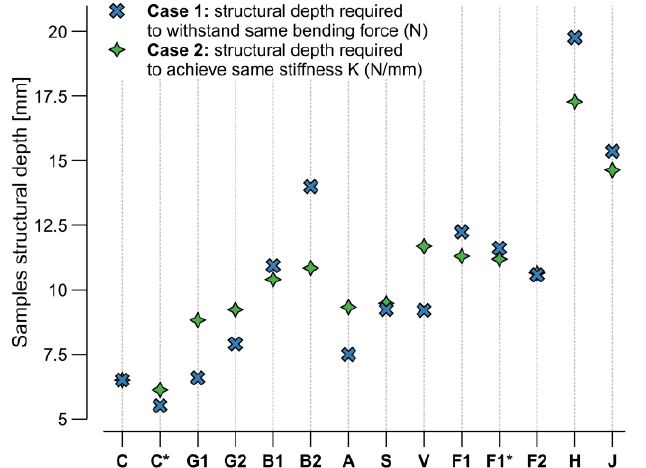
Figure 15. Theoretical sample structural depth of equally performing samples for both cases, Case 1 (strength) and Case 2 (stiffness). C—carbon, C*—carbon with petroleum-based resin, G1—E-glass, G2—S-glass, B1—basalt, type 1, B2—basalt, type 2, A—aramid, S—stainless steel, V—viscose, F1—flax tape, F1*—flax tape with petroleum-based resin, F2—flax yarn, H—hemp,